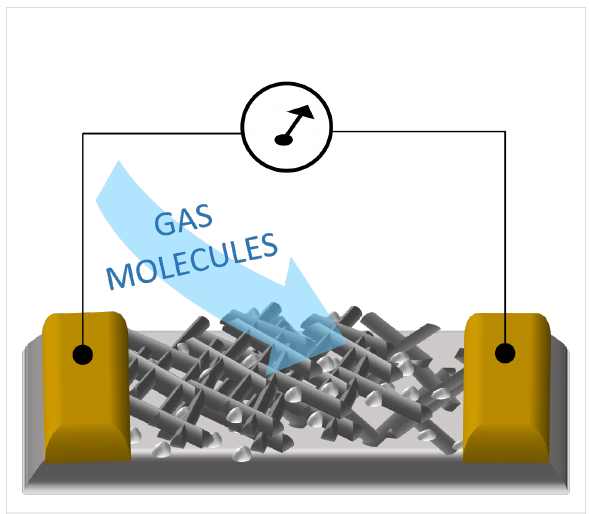
Figure 1: A scheme of a Pd-modified rod-like ZnO-based chemiresis- tive gas sensor.